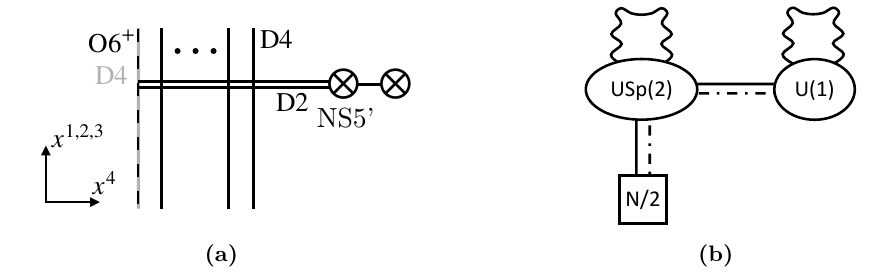
Figure 18. (a): the brane configuration for the monopole screening sector v = 0 of T V · T V in the SO( N ) N = 2 ∗ theory. (b): the corresponding quiver diagram. The wavy lines represent N = (0 , 4) twisted hypermultiplets while the dash-dotted lines represent N = (0 , 4) long Fermi